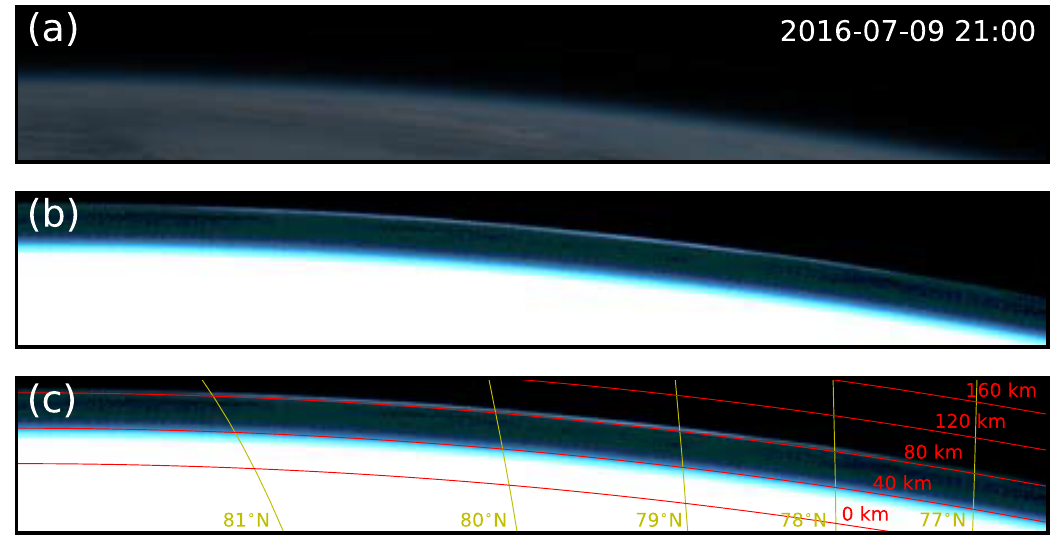
Figure 1. (a) An original true-color image (composite of the three visible bands) around northern high latitudes at 21:00UT on 9 July 2016. (b) Same as (a) , but the color scale is 50 × enhanced. (c) Same as (b) , but latitudes and heights of the tangential points are overlaid.